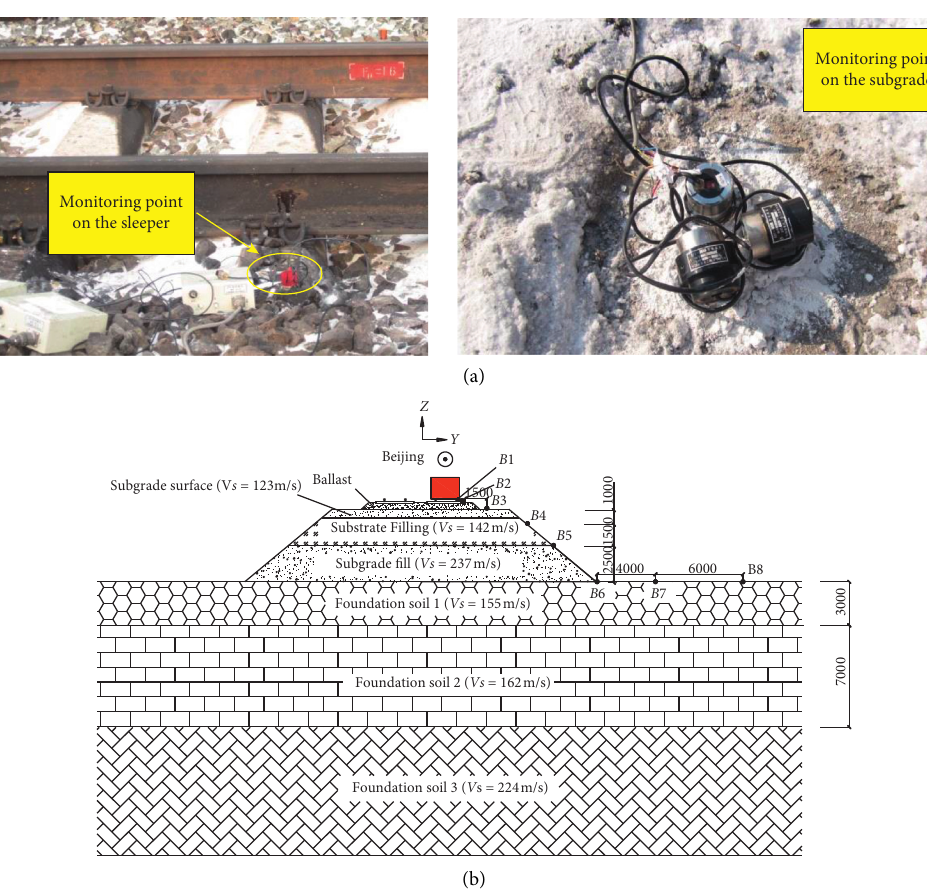
Figure 2: Geometry of monitoring section and layout of sensors in Beijing–Harbin